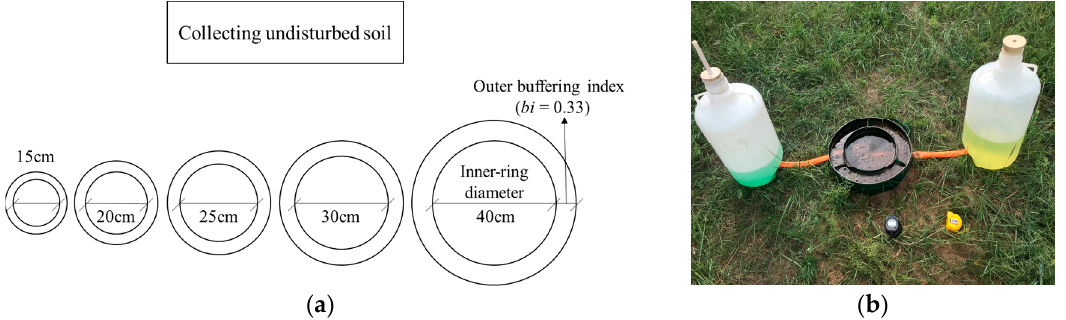
Figure 2. ( a ) Schematic diagram of double-ring infiltration test at each sampling site, and ( b ) experimental equipment.